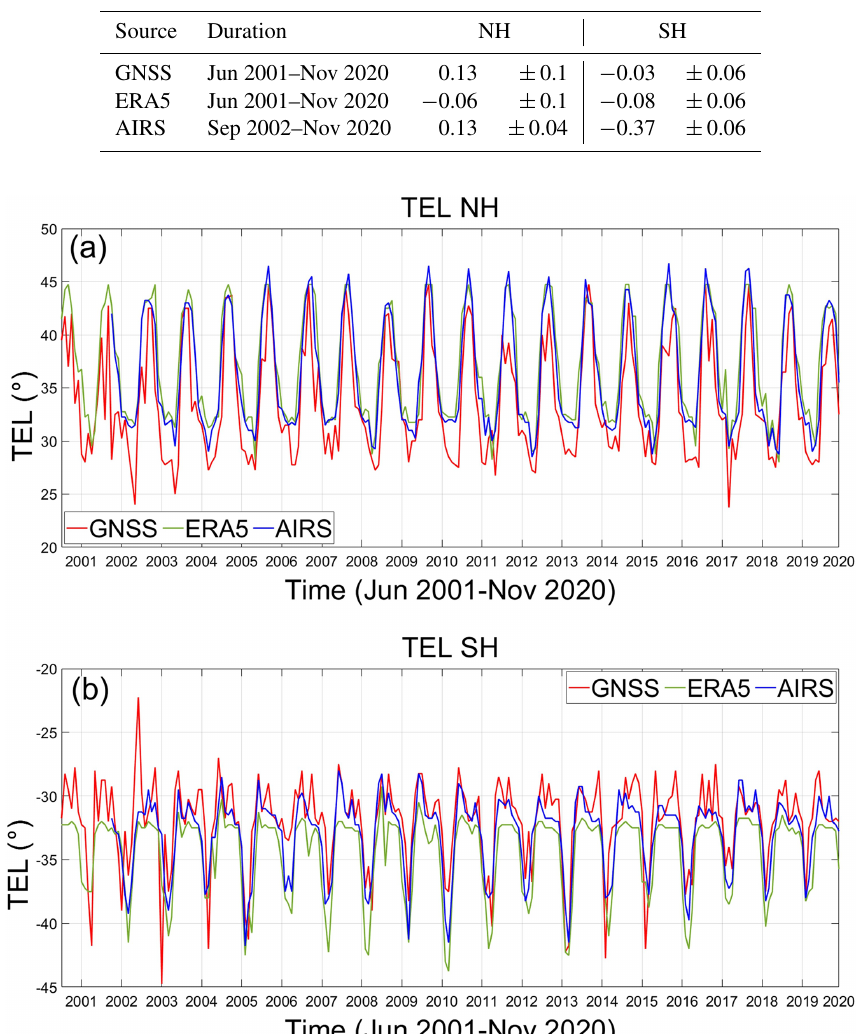
Figure 7. TEL using an objective criterion: (a) NH and (b) SH.